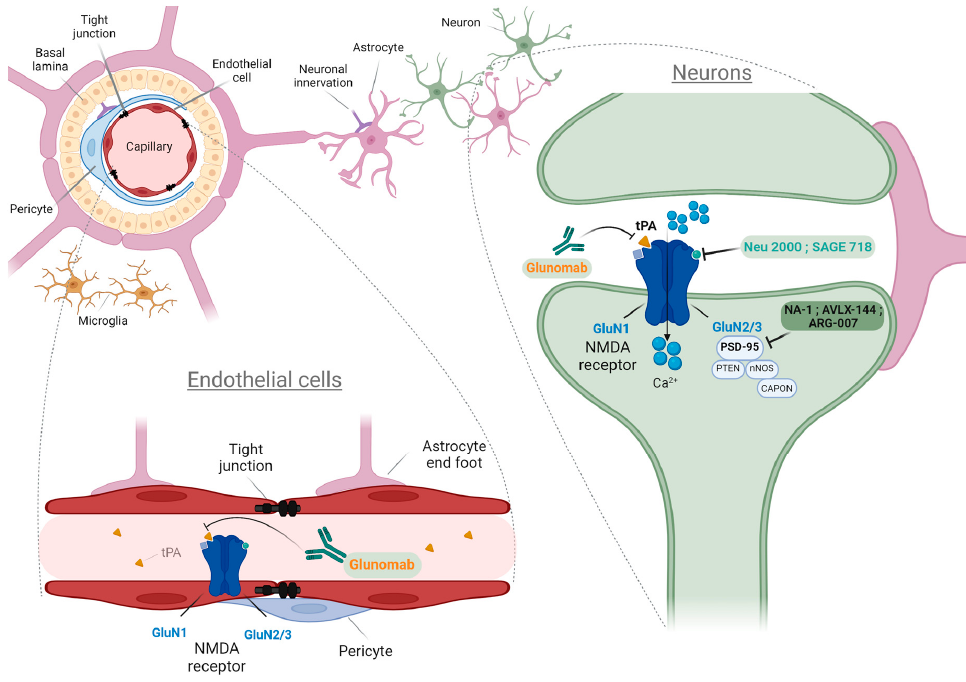
Figure 2. Potential mechanisms of action of innovative therapeutic drugs targeting either neuronal or endothelial